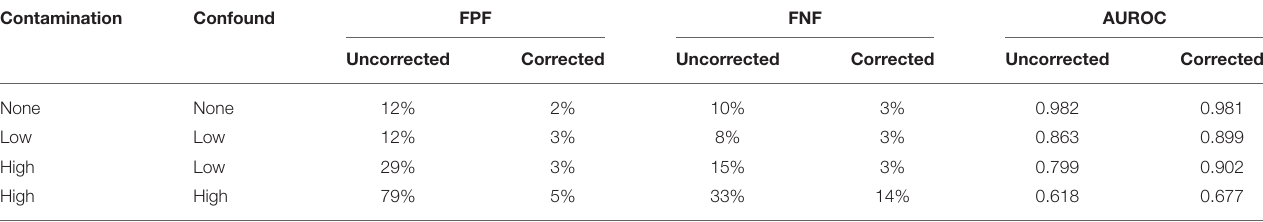
TABLE 1 | Summary of simulation experiments. Contamination Confound FPF FNF AUROC Uncorrected Corrected Uncorrected Corrected Uncorrected